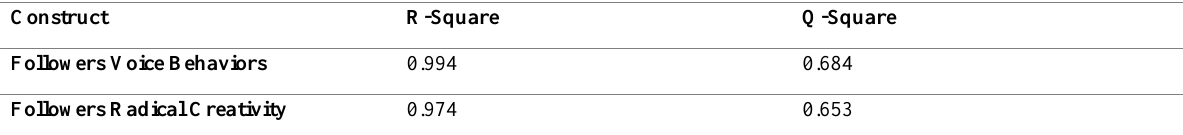
Table 5: Predictive Relevance